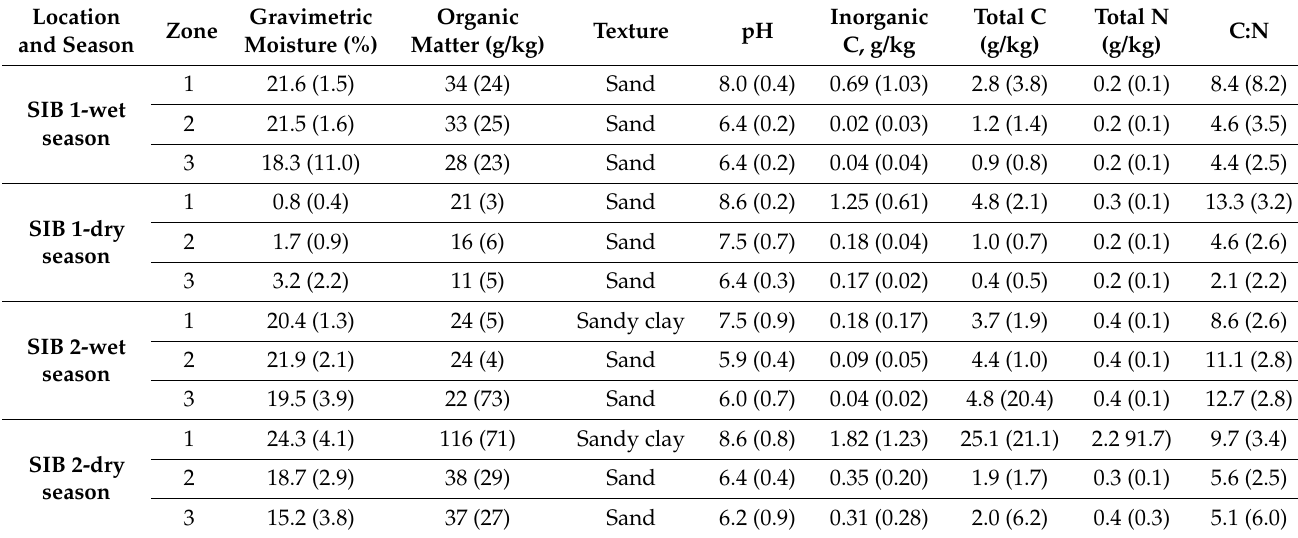
Table 1. Mean SIB soil properties ( ± standard error) at the 0–30 cm depth in the wet and dry season and in the 3 sediment zones. Zone 1, frequently flooded; Zone 2, occasionally flooded; Zone 3, rarely flooded.